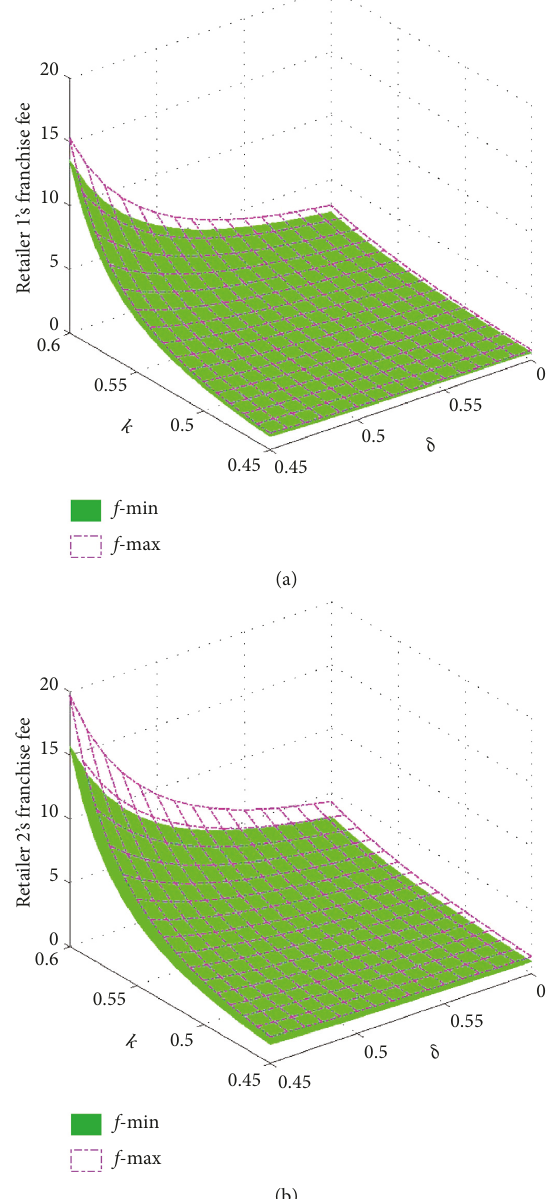
Figure 12: Feasible lower and upper bounds of franchise fees vs. k R R and δ in the M 0 1 2